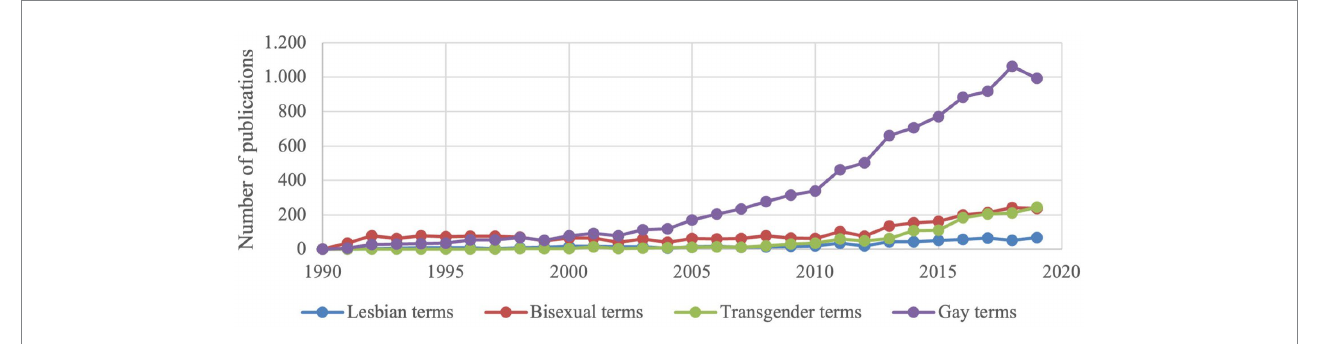
FIGURE 2 The number of publications by years according to the search terms. Some studies had two or more